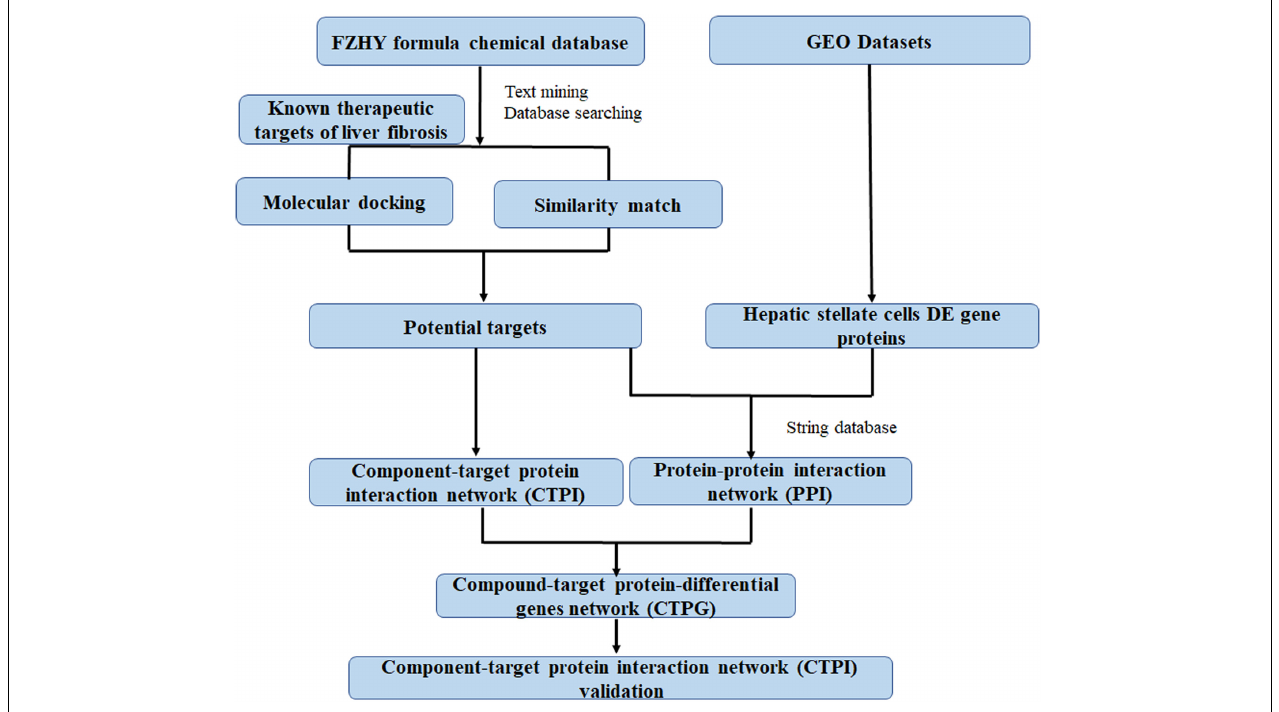
FIGURE 1 | The flowchart of network analysis